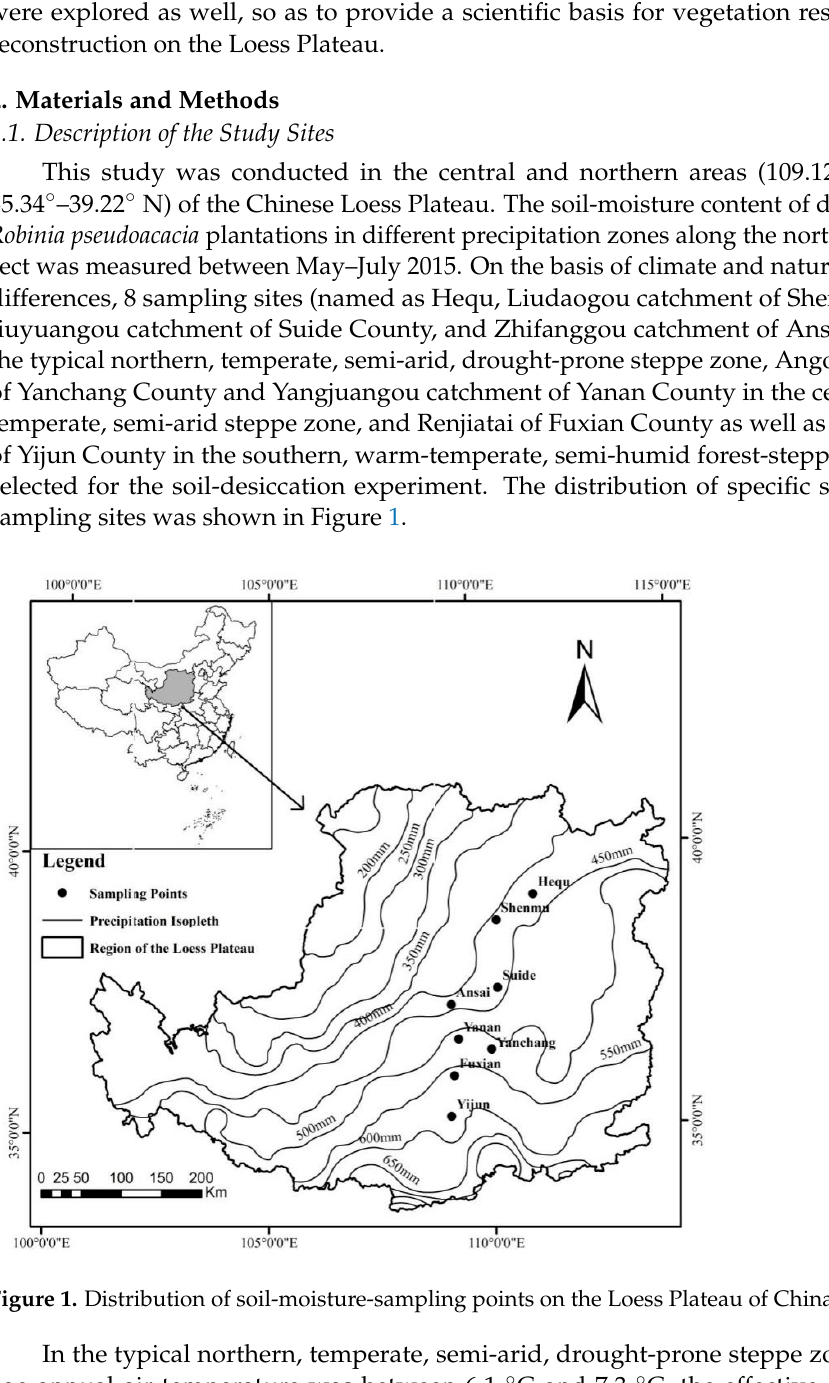
Table 1. Background information of soil-moisture-sampling sites under R. pseudoacacia forests on the Loess Plateau of China.